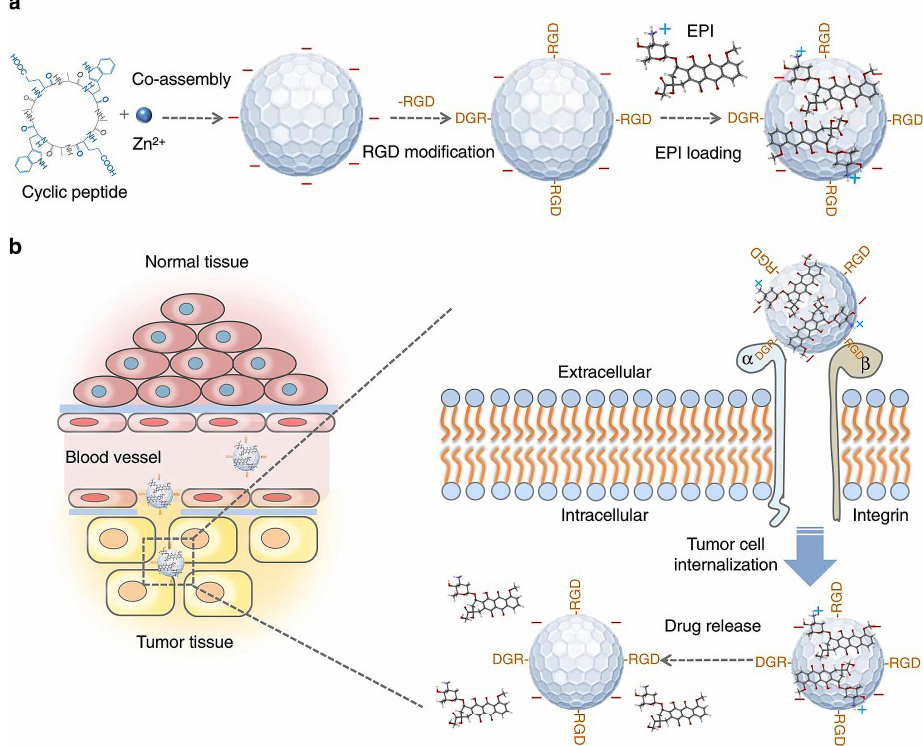
Figure 5. A schematic illustration of the synthesis of RGD-f-PNPs/EPI and its targeted EPI delivery into EC cells. ( a ) The RGD-f-PNPs were first synthesized by co-assembly of Zn 2+ ions and cyclo[-(d- Ala-L-Glu-D-Ala-L-Trp) 2 -] peptides and were then modified with RGD peptide moieties onto the surface of f-PNPs. The EPI was loaded with RGD-f-PNPs through π – π stacking and electrostatic interactions. ( b ) The EPI-loaded RGD-f-PNPs can be used for targeted imaging and destruction of EC cells due to their capability of actively targeting and their enhanced penetration. Specifically, the RGD-f-PNPs/EPI nanoconjugates tend to accumulate more in the tumor tissue compared to normal tissues due to the enhanced permission and retention (EPR effects). Moreover, RGD peptide moie- ties bind to the overexpressed α v β 3 integrin subunits and internalize into EC cells. The embedded EPI is released from the RGD-f-PNPs and eventually accumulates in the nucleus to kill the cancer cells. Reprinted with permission from ref. [92]. Copyright (2018) the author(s).